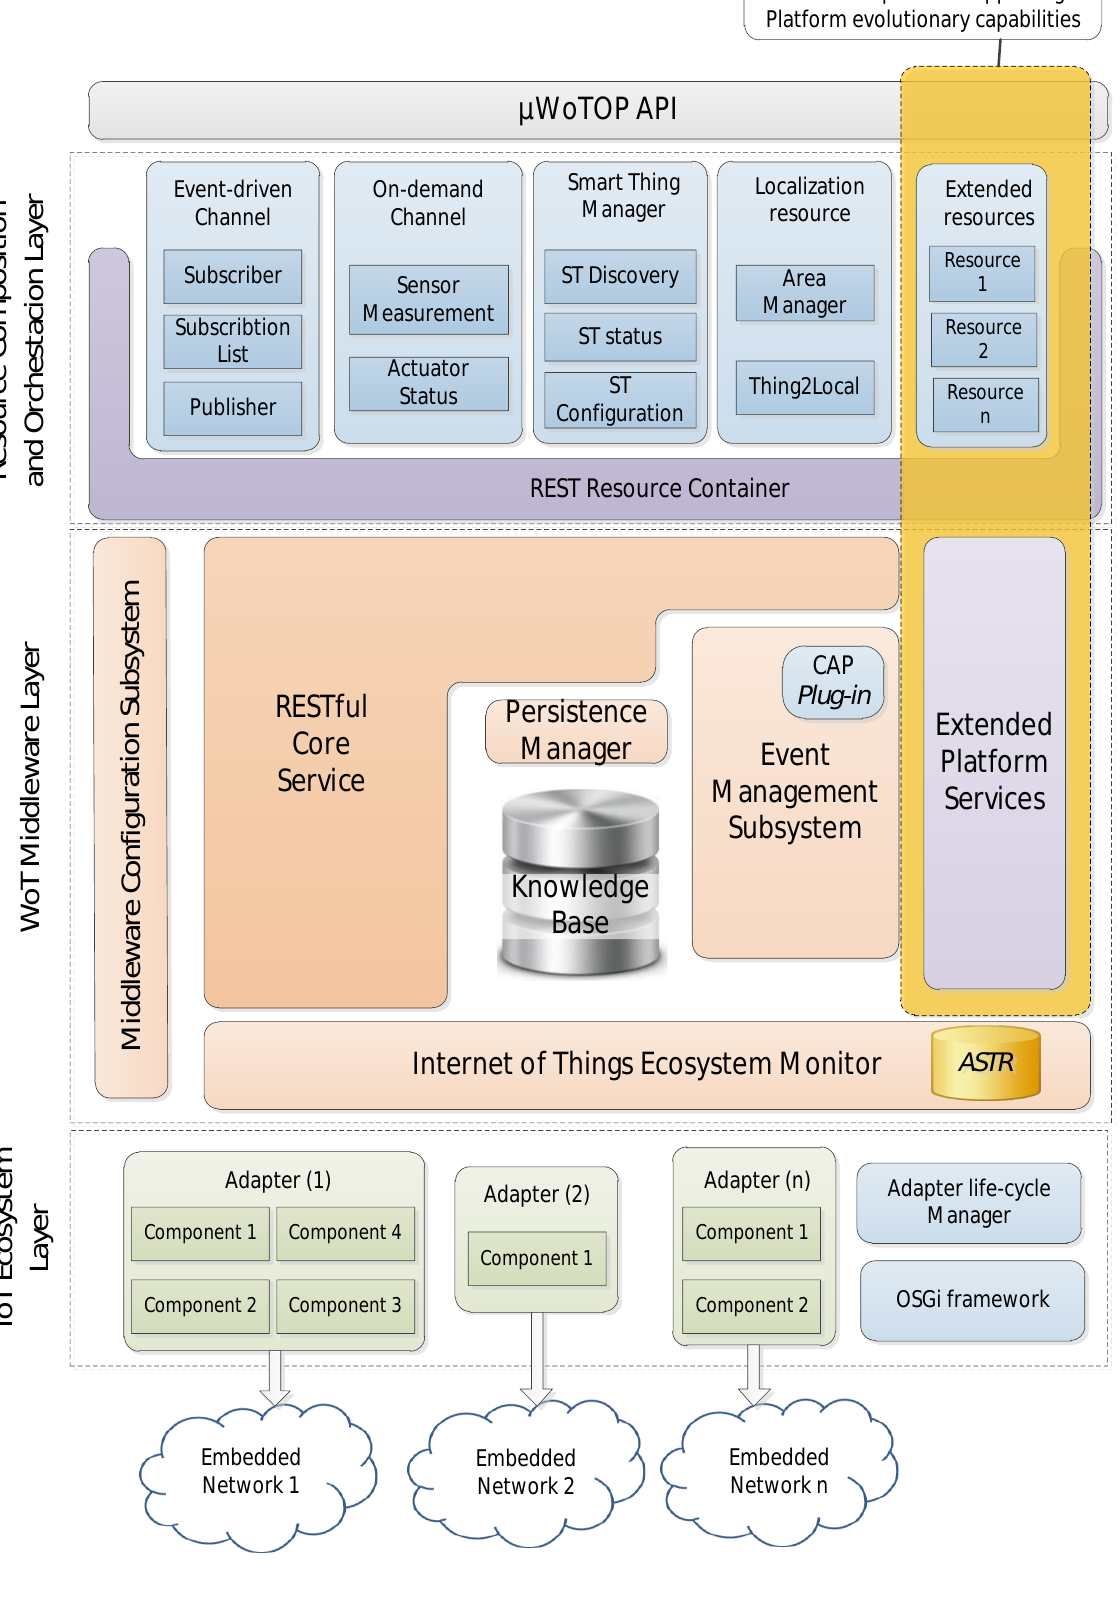
Figure 1. Conceptual diagram of the µ WoTOP’s